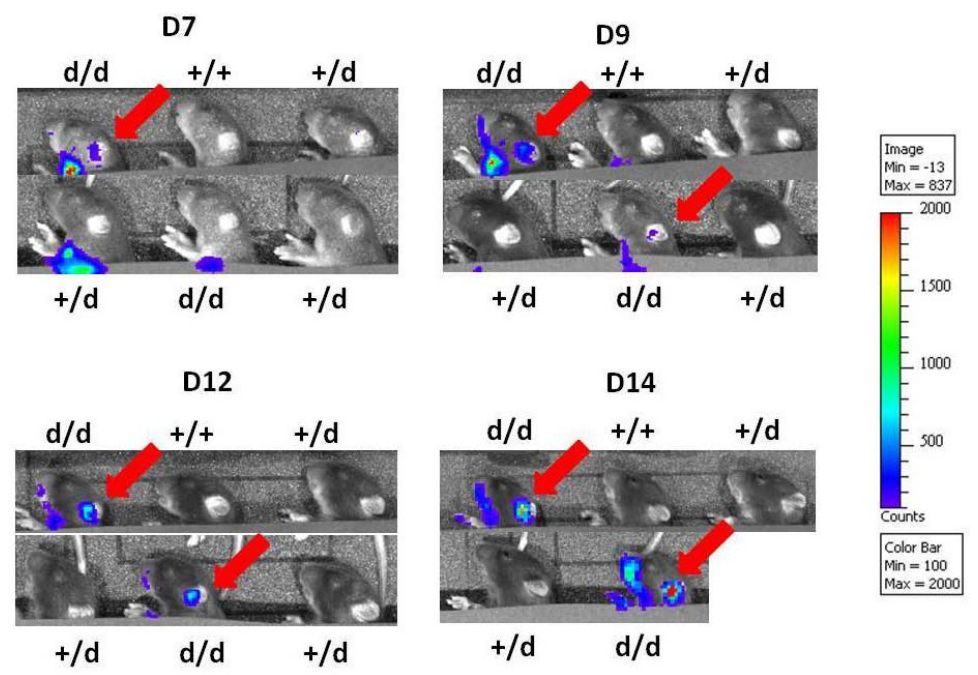
Figure 3. Preferential viral dissemination in the head of Dicer d/d mutants following MCMV neonatal infection. The abdomen of the animals was covered with dark cardboard to hide luminescence emitted from the lungs, spleen, liver or kidneys in order to increase the exposure time and to detect photons originating from the head region only. Data were obtained at days 7, 9, 12, and 14 following MCMV-Luc injection. Genotypes are indicated. To unambiguously demonstrate the presence of the virus in the brain and to locate its replication sites we performed Immunohistochemistry (IHC) staining on frozen brain sections from